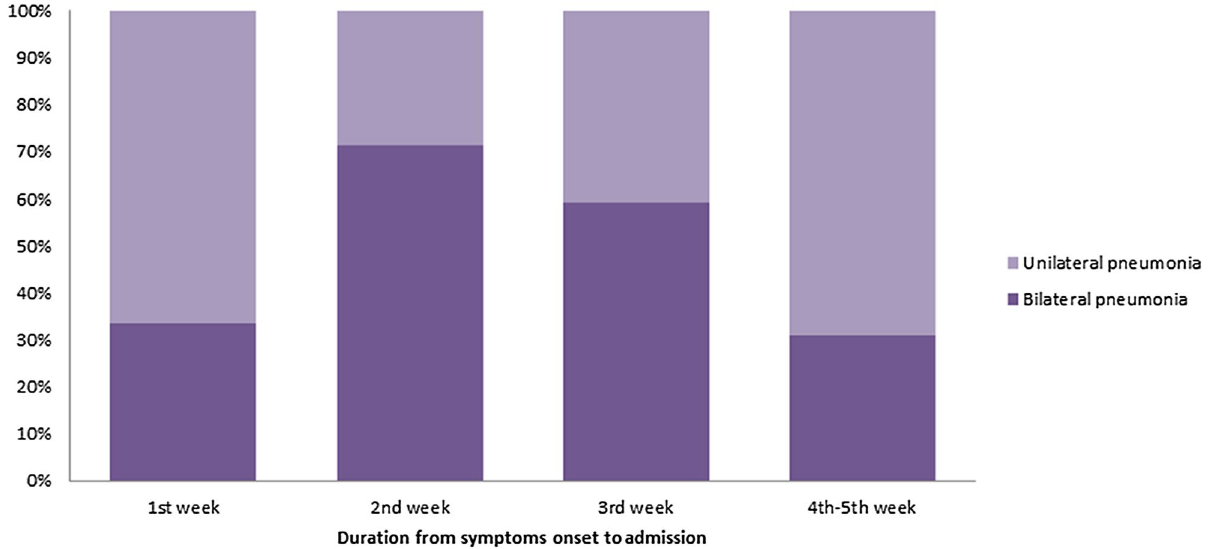
Figure 2. Dynamic profiles of abnormal chest imaging over time in non-severe patients with COVID-19. Pneumonia occurred early in the course of illness and bilateral pneumonia was also observed in the first week after symptoms onset. In the second week after symptoms onset, pneumonia progressed and the highest incidence of bilateral pneumonia was observed during this period. After that, pneumonia improved since the third week after symptoms onset and still had somewhat abnormal chest imaging during the fourth to the fifth